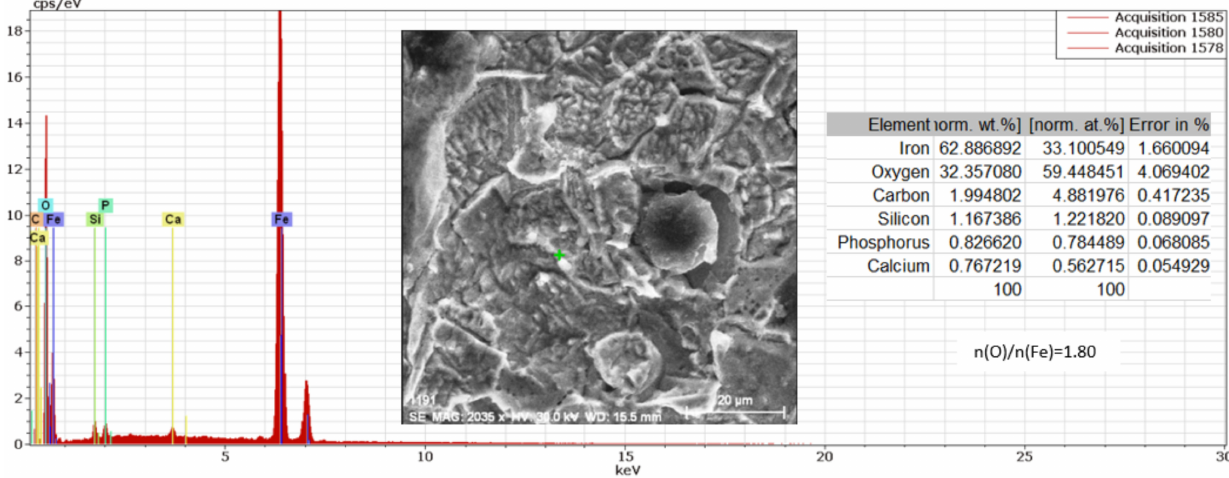
Figure 17. EDS results for the sample immersed for 65 days in DWW-1.